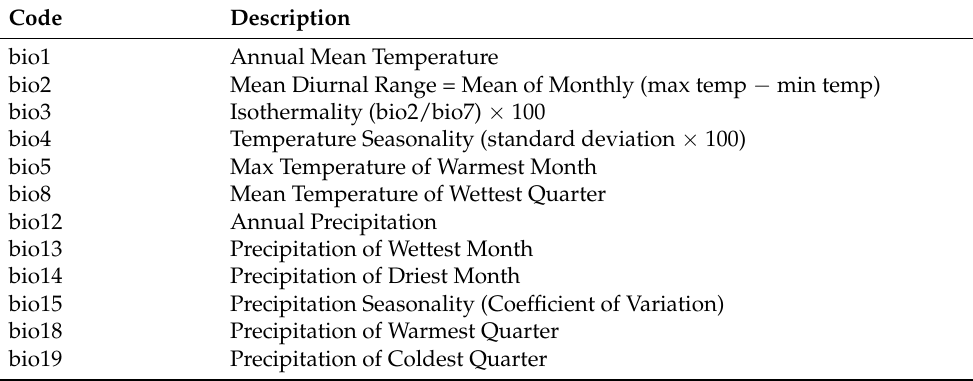
Figure 1. Distribution of studied genera. Base map of ecoregions developed by Olson [28] . Table 1. Codes of climatic variables used in this study.